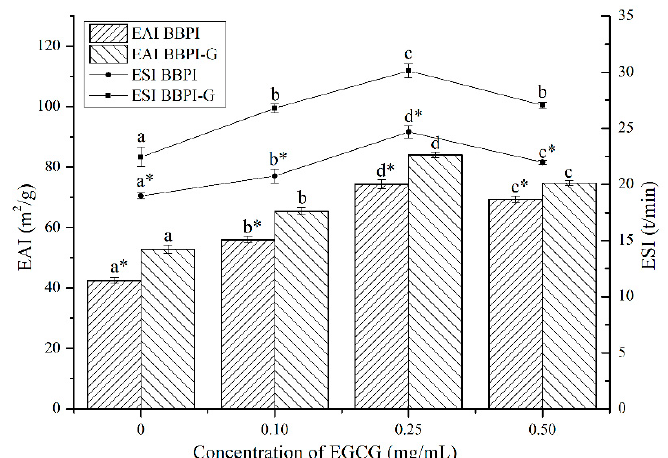
Figure 3. Emulsifying properties (EAI and ESI) of the BBPI and BBPI-G with di ff erent concentrations of EGCG prepared oil-in-water emulsions. a–d means with di ff erent letters di ff er significantly in the same protein with di ff erent concentrations of EGCG ( p < 0.05). * means di ff er significantly between BBPI and BBPI-G ( p < 0.05).